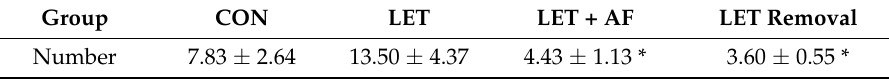
Table 3. Number of follicular